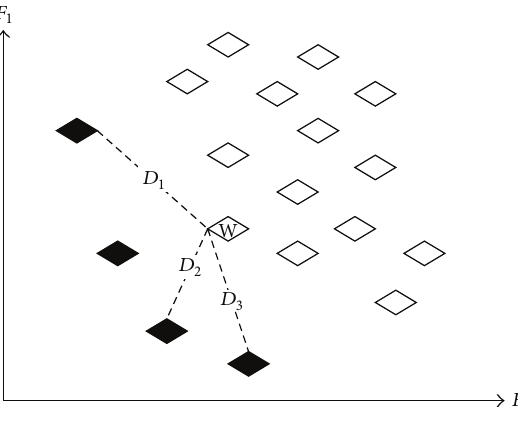
Figure 2: Tournament